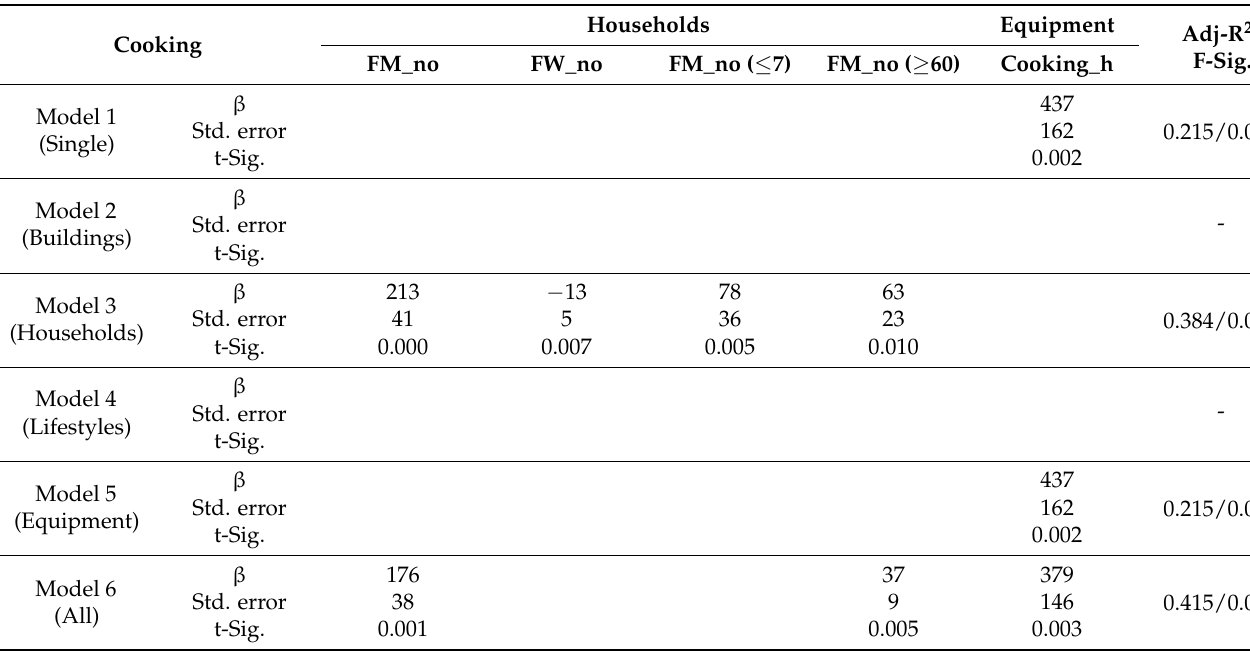
Table 10. Analysis results of valid determinants for